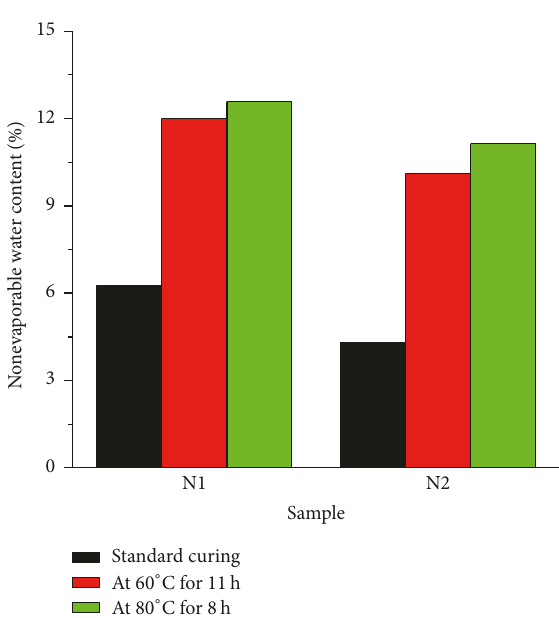
Figure 10: Nonevaporable water contents of the pastes containing phosphorus slag with W/B of 0.4 at the age of 90d.